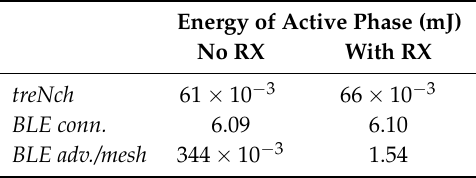
Table 5. Use case of node with critical power input.